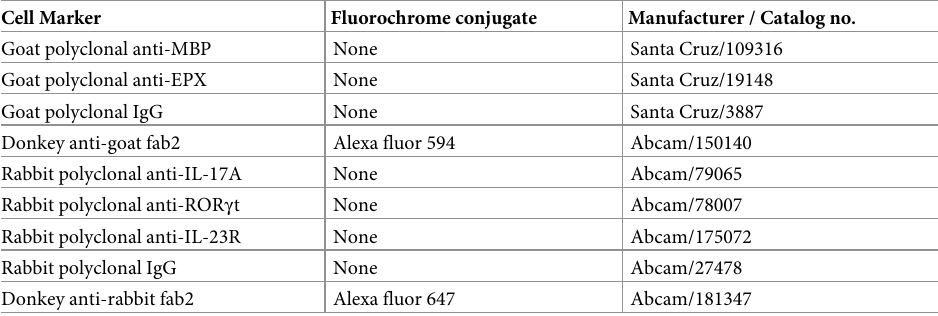
Table 2. Antibodies used for confocal